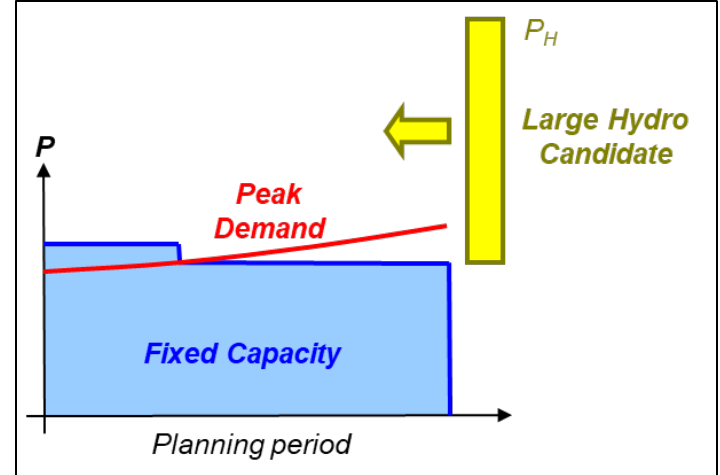
Figure 8. Large hydro plant candidate in a small power system.